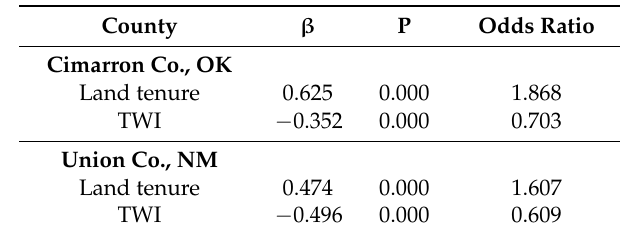
Table 5. Logistic regression results for predicting woody plant encroachment based on land tenure and the topographic wetness index